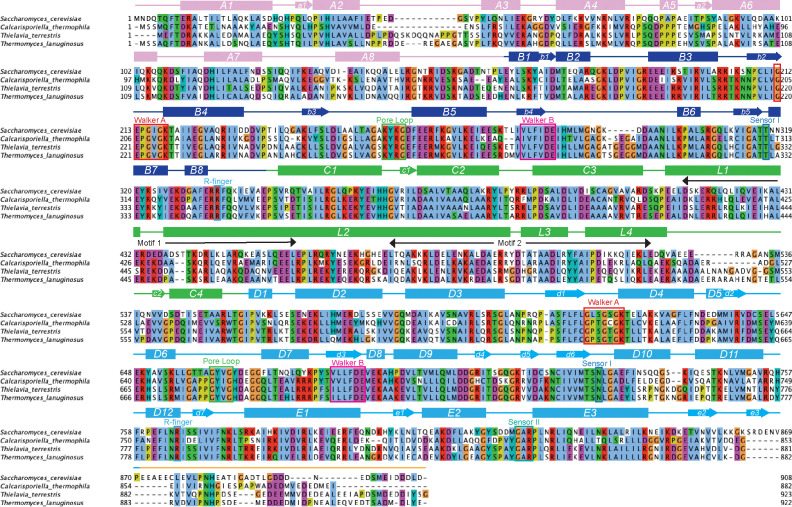
Alignment comparing ScHsp104 to Hsp104 homologs that rescue αSyn toxicity.Amino acid sequences of the indicated Hsp104 homologs were aligned using Clustal Omega, and the multiple sequence alignment was visualized with JalView. Amino acids are colored according to Clustal X convention: conserved hydrophobic positions (A,I,L,M,F,W,V,C) are blue; conserved basic residues (K,R) are red; acidic residues (E,D) are magenta; polar residues (N,Q,S,T) are green; aromatic residues (H,Y) are cyan; conserved cysteines are pink; glycines are orange, prolines are yellow. Structural elements of Hsp104 are indicated.